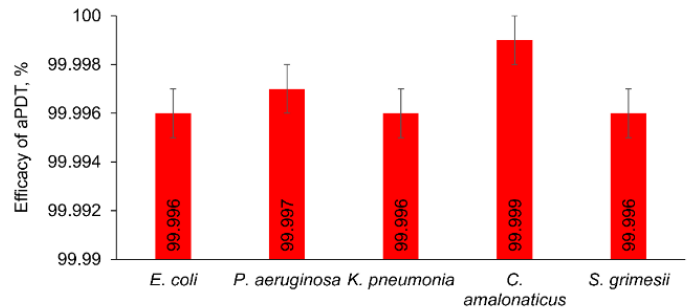
Figure 6. Efficacy of aPDT of Gram-negative bacteria in urine culture. Bacteria were incubated with Fotoditazin and Triton X-100 for 15 min at room temperature in the dark, and illuminated by continuous wave laser at 450 mW of output power.